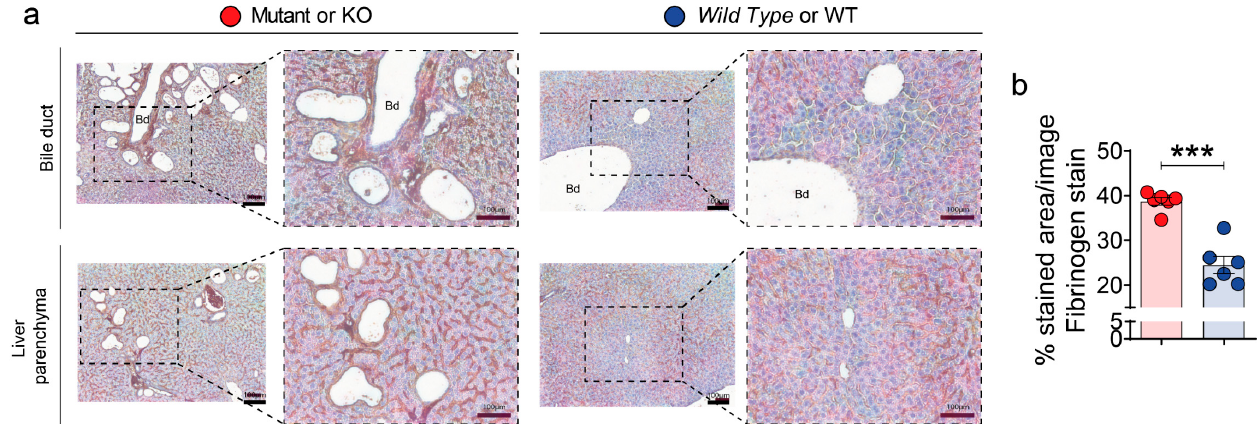
Figure 7. Fibrinogen complex is up ‐ regulated in the cystic epithelia. ( a , b ) Representative images of fibrinogen immunohistochemistry in bile duct (upper panel) and liver parenchyma (lower panel) ( a ) and its quantification ( b ). n = 6 was used for each group. The immunohistochemistry analysis showed an up ‐ regulation of fibrinogen through cystic epithelia. The samples corresponded to p12 group. Scale bars represents 100 μ m. Bd means bile duct. Bars represent means ± SEM. Student’s t ‐ test with two ‐ tail was used and a value of p < 0.05 was considered significant. *** p < 0.001.